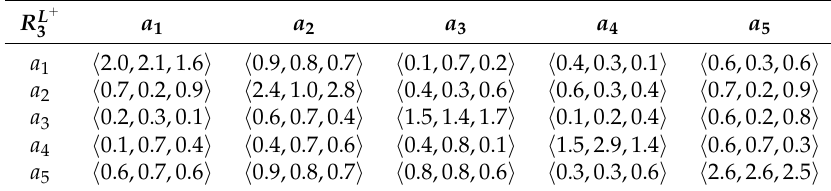
Table 11. Elements of the signless Laplacian matrix of the SVNDG